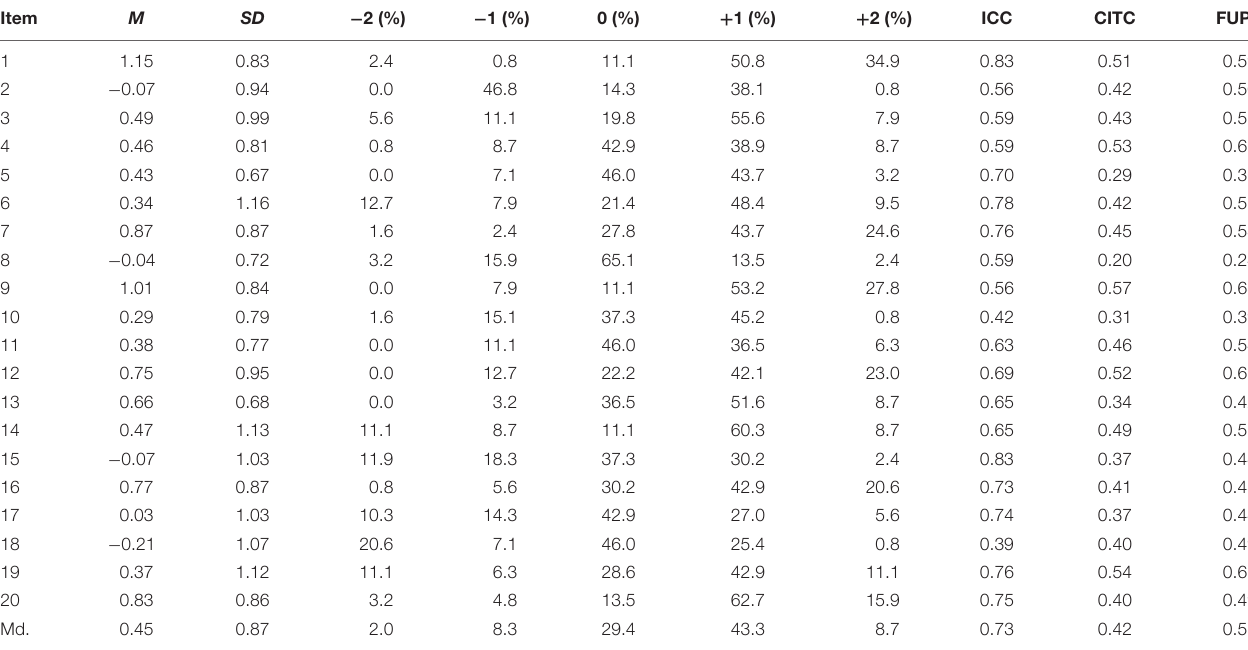
TABLE 3 | Descriptive statistics, psychometric properties, interrater agreement, and the frequency distribution of the ratings of responses for the pilot version of the Picture-Geloph (Study 1).